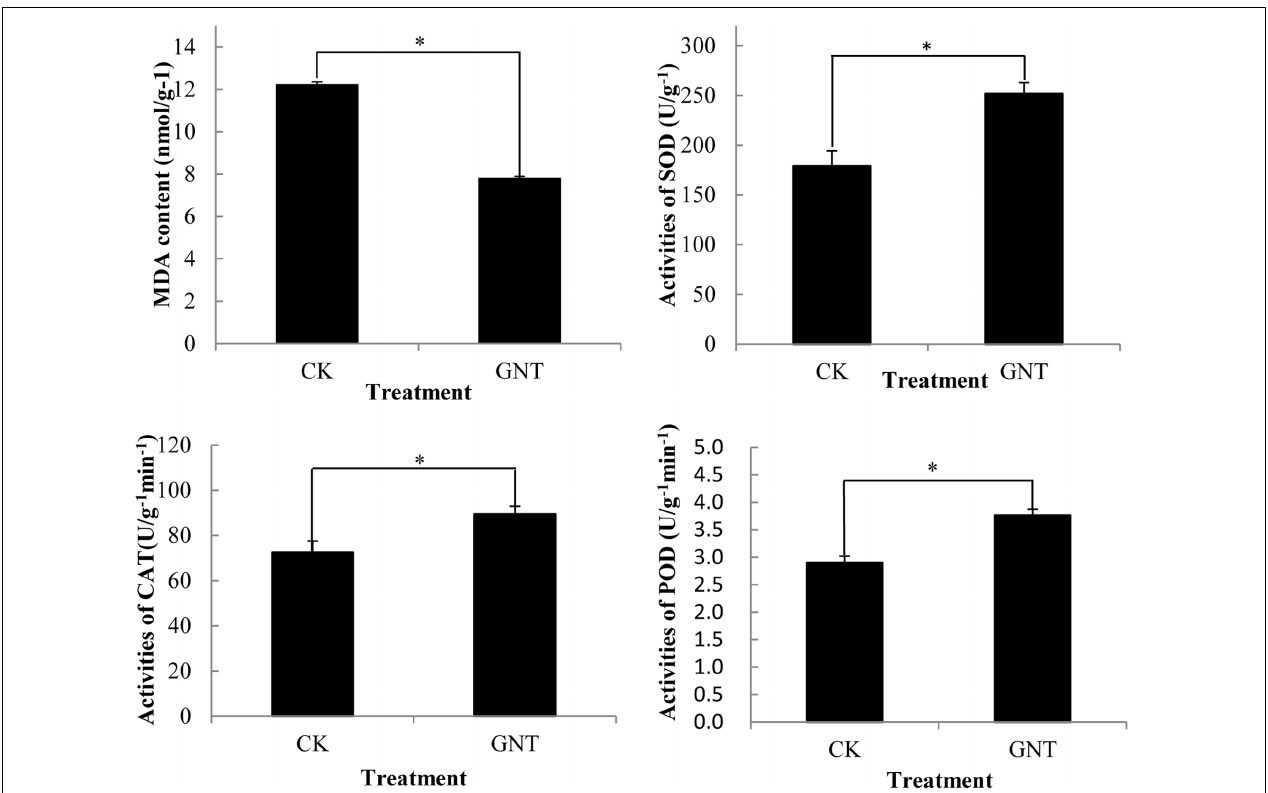
FIGURE 7 | Genistein treated cabbage showed lower MDA levels and higher antioxidant system enzyme activites. The data are mean ± SD ( n = 3), Vertical bars represent ± SD. The symbol ∗ represents significant difference with CK treatment at P = 0.05